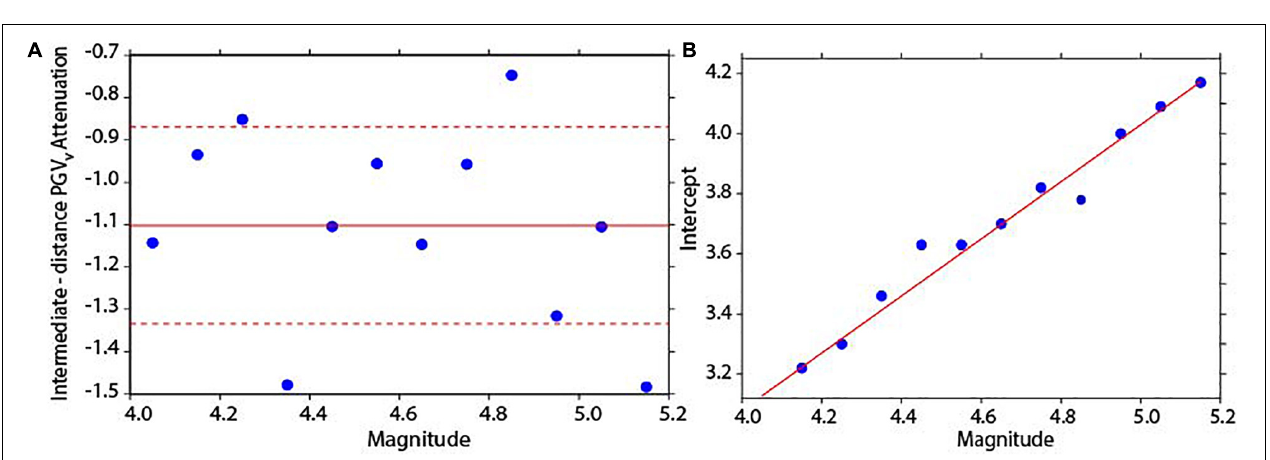
FIGURE 12 | (A) Intermediate-distance PGV V attenuation c plotted for magnitude bins. Data points beyond the 1 σ variability (0.30, red dashed lines) of the raw mean (–1.39, solid red line) are trimmed and the median of the remaining PGV V attenuation provided parameter c in Eq. 1, which is found to be –1.03 across the dataset. (B) Fitting the distance and PGV V data for each magnitude window using the constant slope value c to find the slope and intercept of the magnitude dependence (respectively b and a in Eq. 1), regressed using the linear least squares.